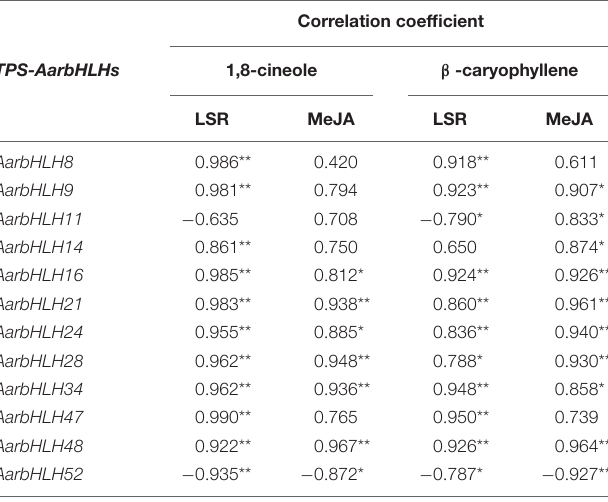
TABLE 3 | Correlation analysis between the contents of 1,8-cineole and β -caryophyllene and expression of candidate TPS-AarbHLHs . Correlation